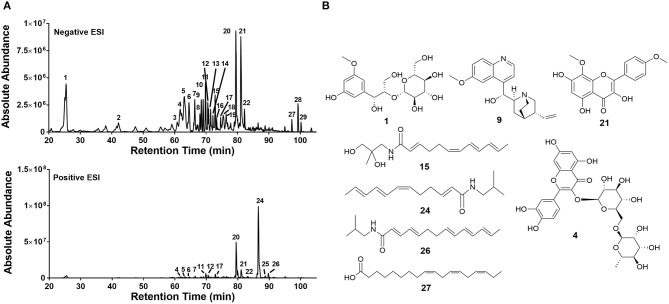
Chemical characterization of extract 1290. (A) LC-FTMS ESI negative and positive base peak chromatograms for 430D-F5. All peaks correspond to data presented in Table 4. (B) Putative structural matches are listed by peak number. Peak 1 was determined to be C16H24O10 and the putative structural match is threo-3-methoxy-5-hydroxy-phenylpropanetriol-8-O-β-D-glucopyranoside. Peak 4 was determined to be C27H30O16 and the putative structural match is 3-[[6-O-(6-deoxy-α-L-mannopyranosyl)-β-D-glucopyranosyl]oxy]-2-(3,4-dihydroxyphenyl)-5,7-dihydroxy-4H-1-benzopyran-4-one. Peak 9 was determined to be C20H24N2O2 and the putative structural match is 6'-methoxy-(8α,9R)-cinchonan-9-ol. Peak 15 was determined to be C16H25N O3 and the putative structural match is N-(2,3-dihydroxy-2-methylpropyl)-2,6,8,10-dodecatetraenamide. Peak 21 was determined to be C17H14O7 and the putative structural match is 3,5,7-trihydroxy-8-methoxy-2-(4-methoxyphenyl)-4H-1-benzopyran-4-one. Peak 24 was determined to be C16H25NO and putative structural match is N-(2-methylpropyl)-2,6,8,10-dodecatetraenamide. Peak 26 was determined to be C18H27NO and the putative structural match is N-(2-methylpropyl)-2,4,8,10,12-tetradecapentaenamide. Peak 27 was determined to be C18H30O2 and the putative structural match is 9,12,15-Octadecatrienoic acid.